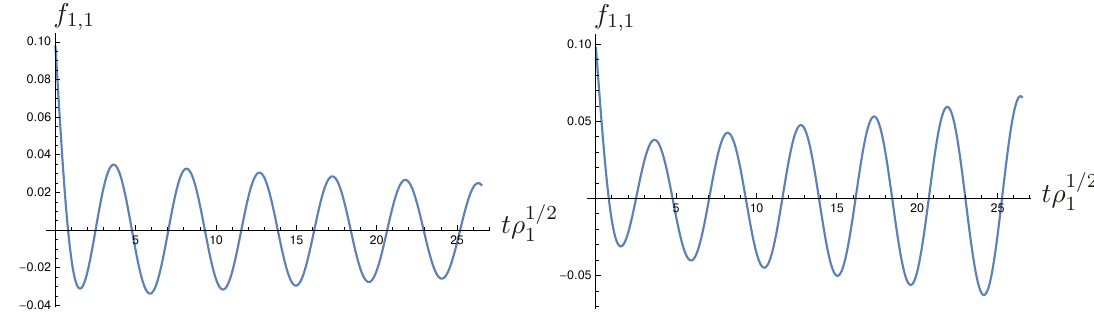
= 1 . 01538 crit (symmetric phase is stable); right E E = 0 . 976328 crit E E